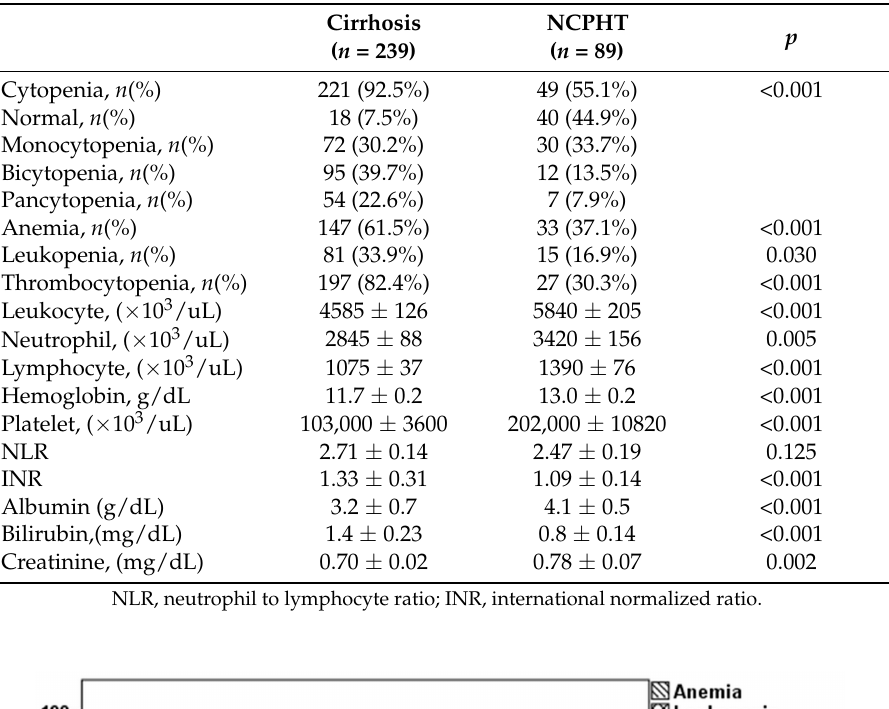
Table 2. Hematological indices in patients with cirrhosis and patients with NCPHT.